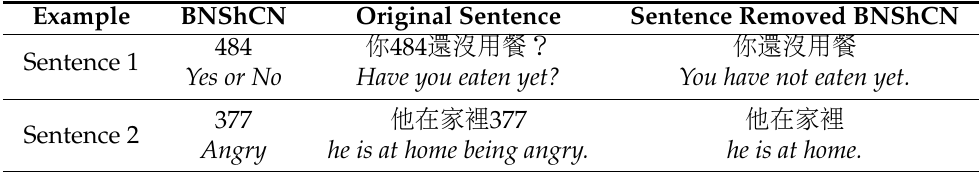
Table 1. Sample sentence after pre-processing by default